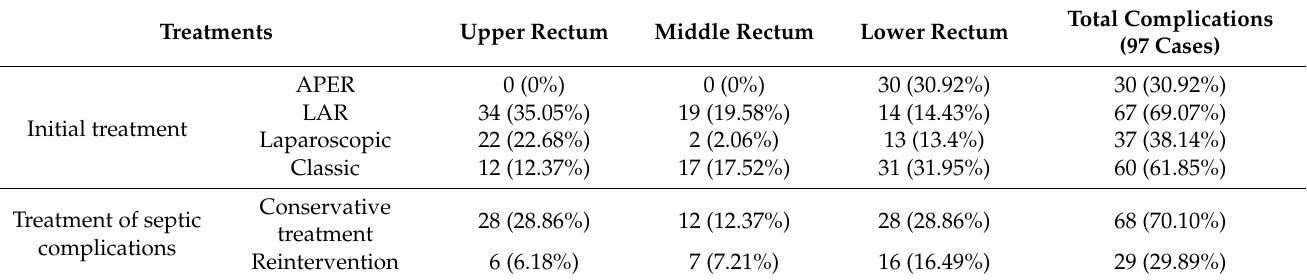
Table 1. Specific complications related to the type of treatment.